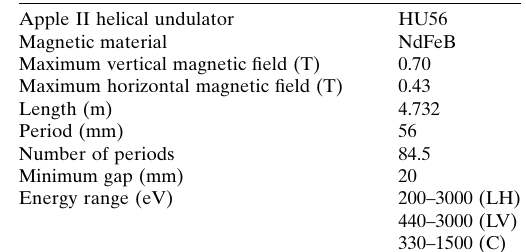
Table 3 Undulator parameters. Apple II helical undulator